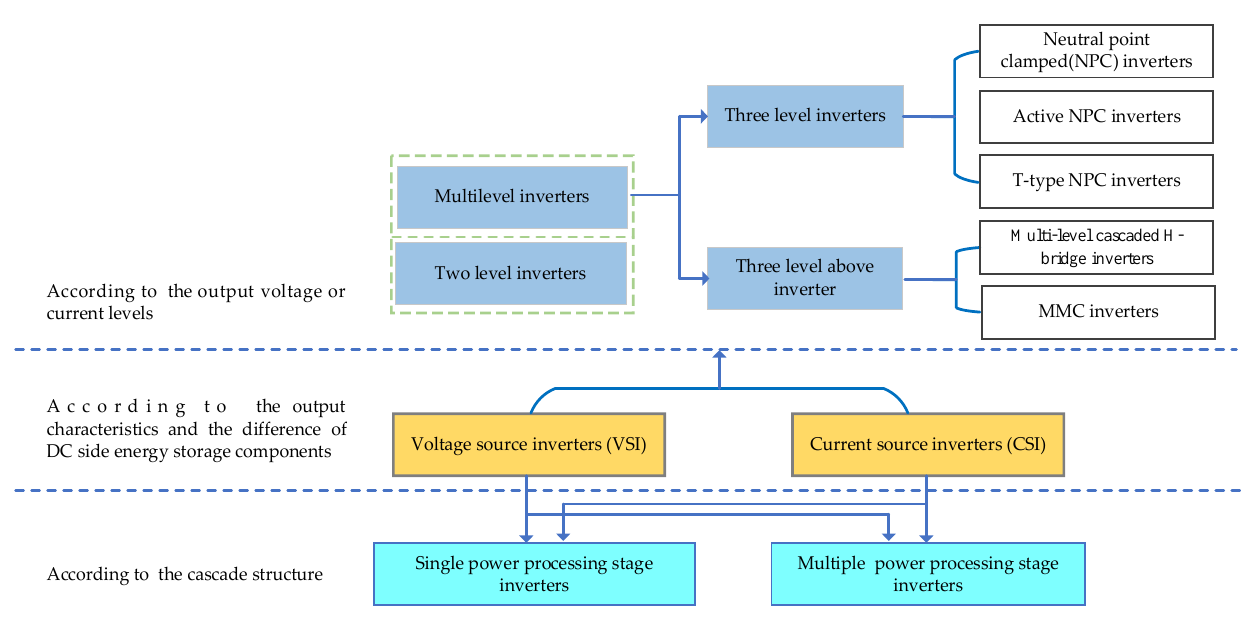
Figure 5. The types of grid-connected inverters.